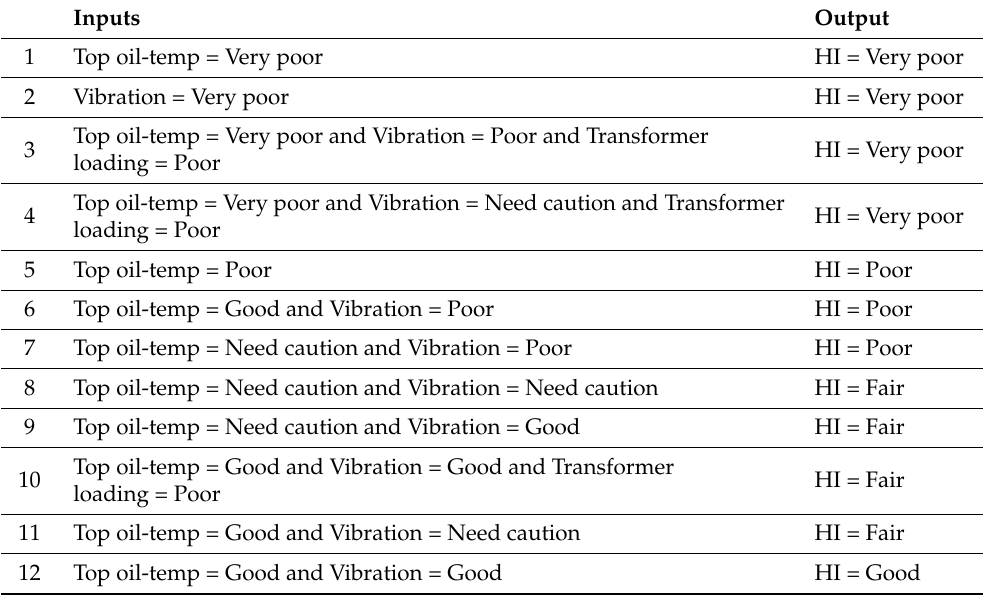
Table 2. Fuzzy logic expert rules for assessing health